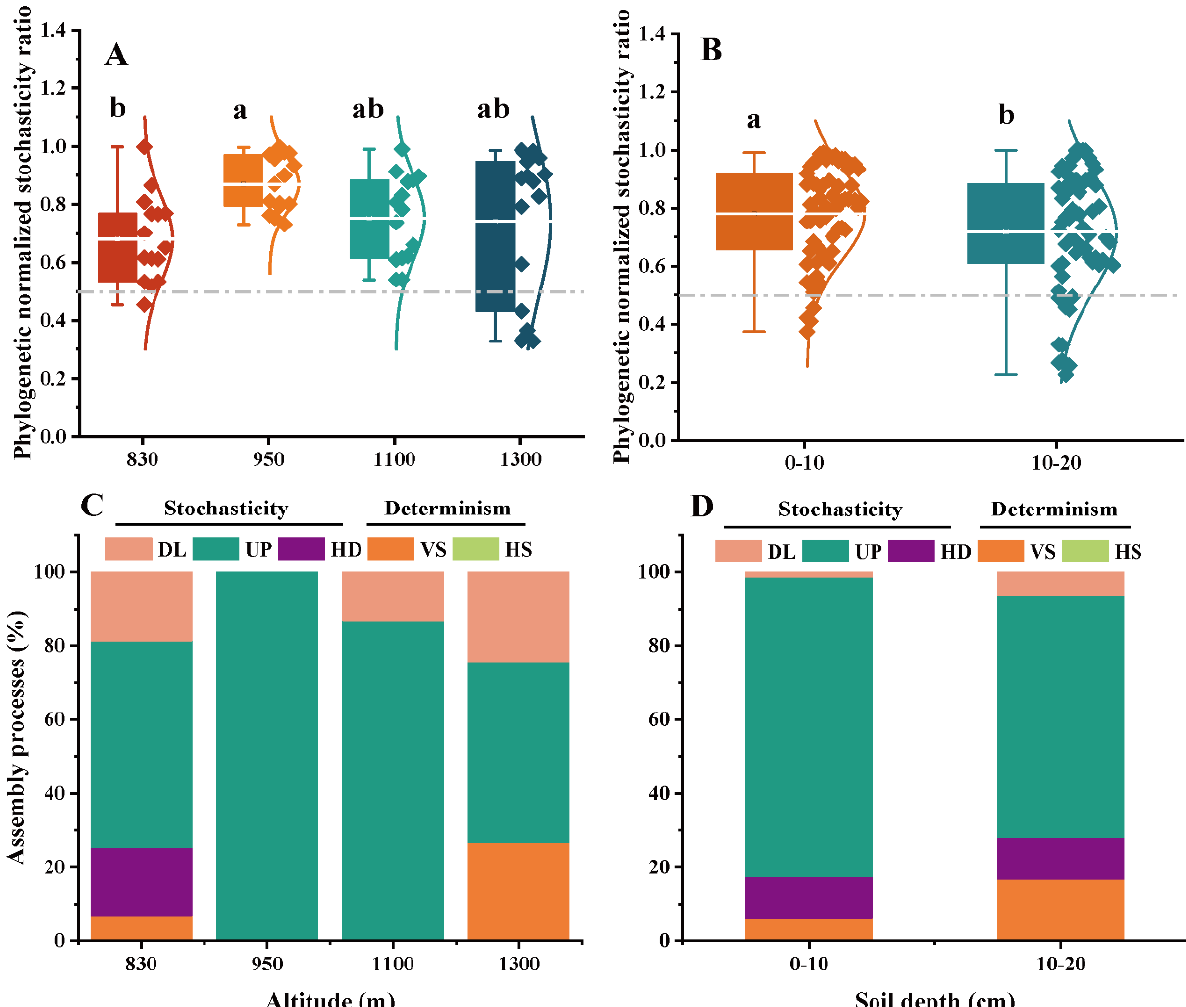
Figure 5. The ecological stochasticity in the potential SAP fungal community assembly is estimated by the phylogenetic normalized stochasticity ratio (pNST). ( A ) Ecological stochasticity among dif- ferent altitudes; ( B ) ecological stochasticity between different soil layers. The values < 0.5 and >0.5 represent the deterministic and stochastic assembly, respectively. The relative contributions (%) of the community assembly processes in shaping SAP fungal communities at different altitudes ( C ) and soil layers ( D ). Different lowercase letters denote significant differences at different altitudes (or different soil layers) ( p < 0.05). Differences between 0–10 cm and 10–20 cm soil layers were examined using a Student’s T -test. Differences among different altitudes were examined using Tukey’s HSD test. HS, homogeneous selection; VS, variable selection; HD, homogenizing dispersal; UP, undominated process; DL, dispersal